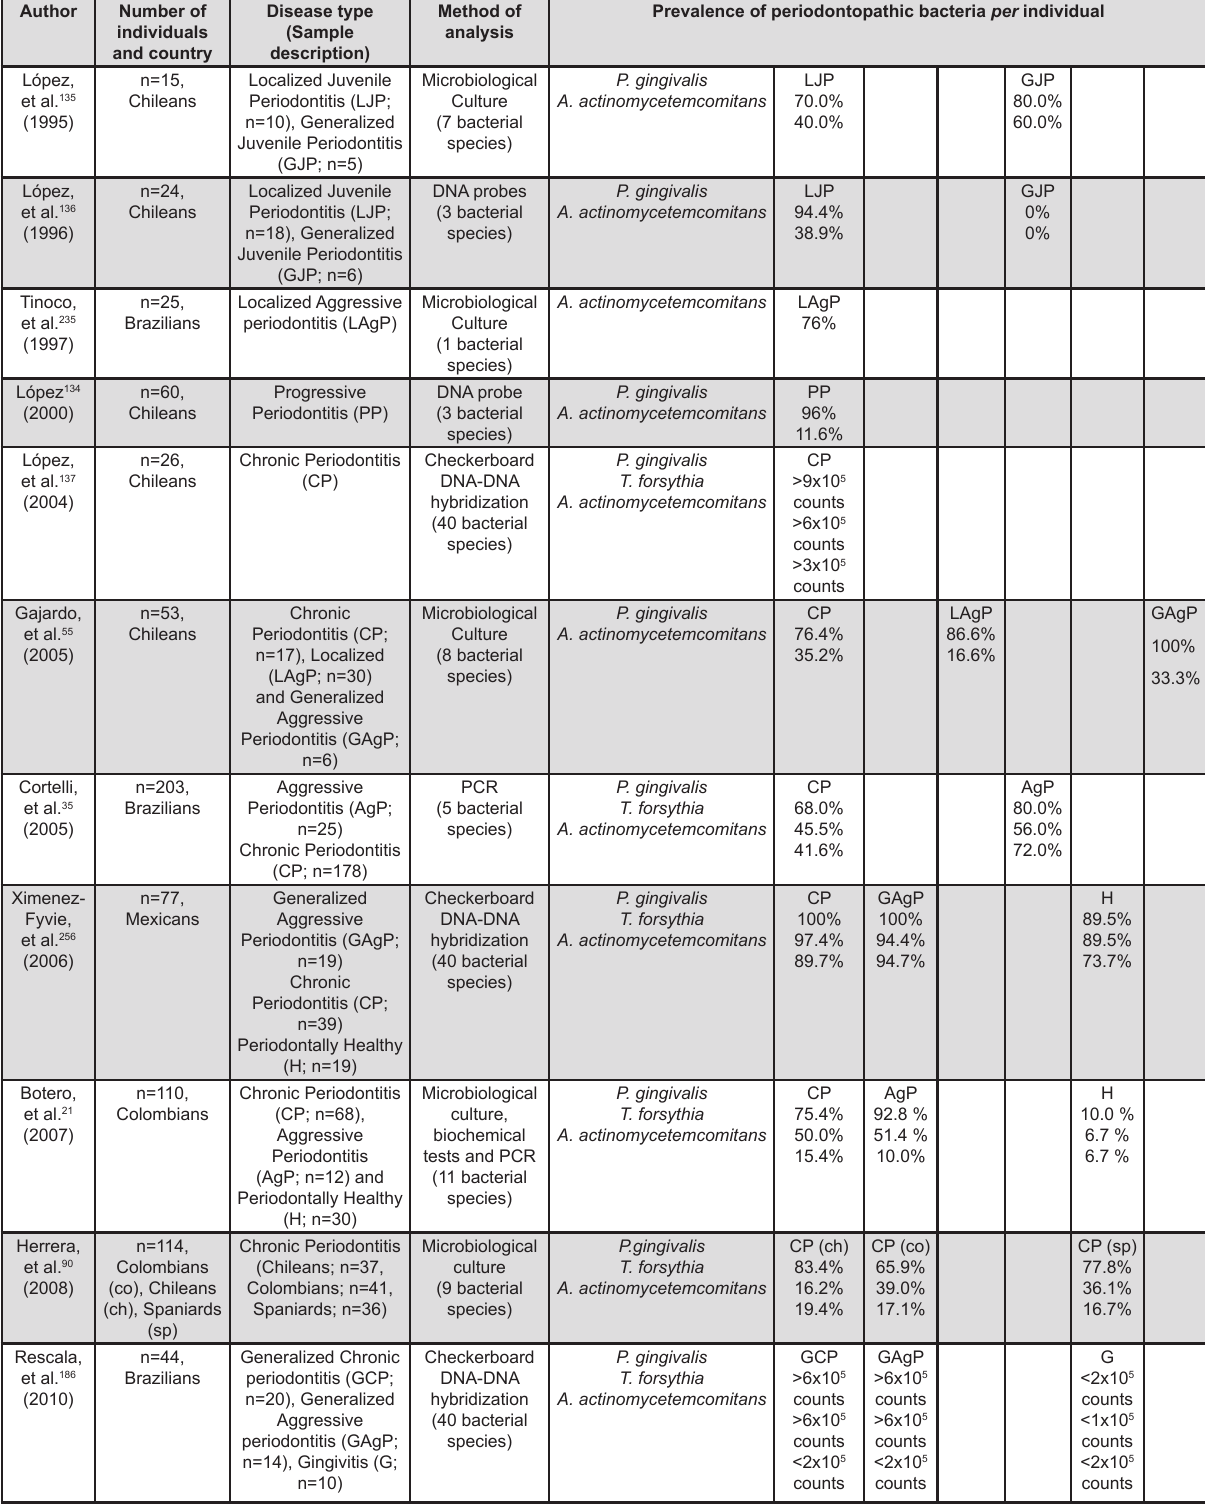
Figure 1- Comparison of the frequency of detection of Porphyromonas gingivalis , Tannerella forsythia and Aggregatibacter actinomycetemcomitans in Latin American subjects with different periodontal